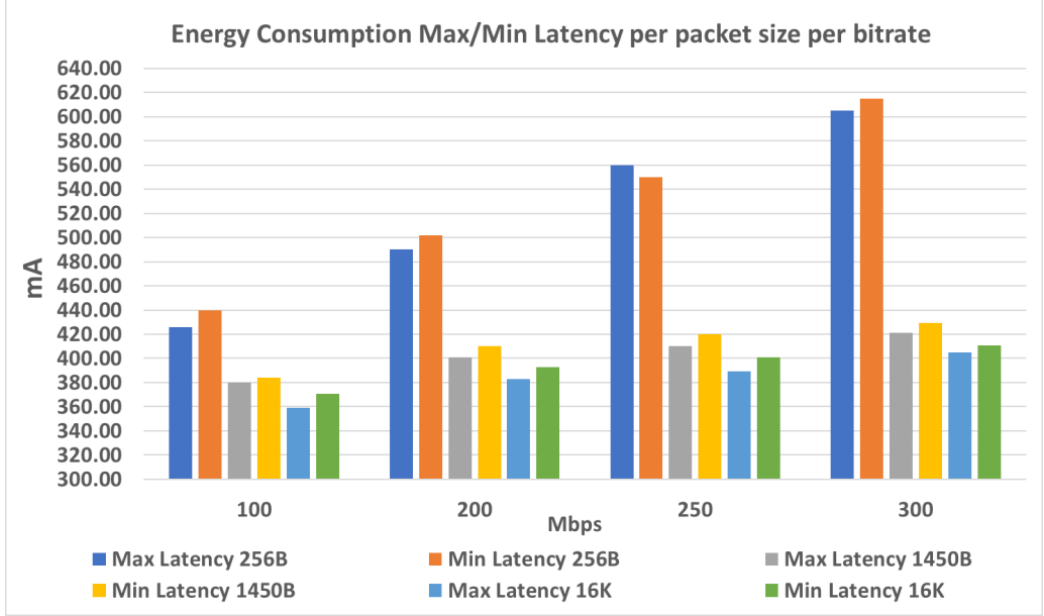
Figure 7. Energy consumption for different eMBB slices in conjunction with URLLC slicing config- urations.